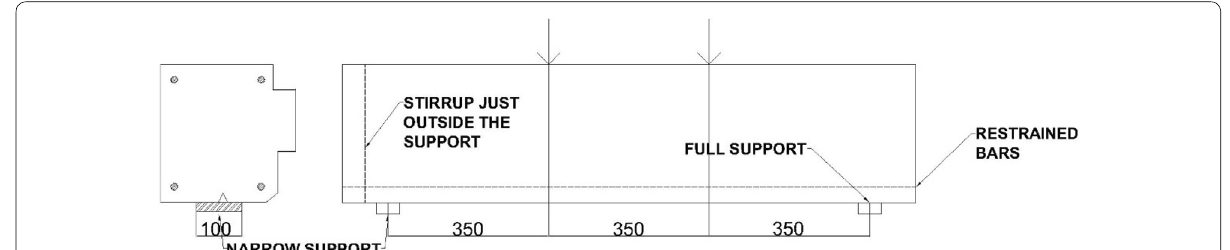
Fig. 8 Directly supported four-point-bending test setup. Dimensions are in mm.